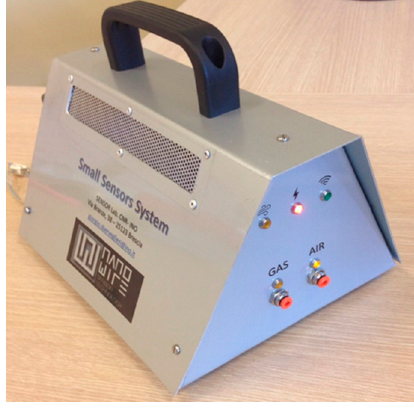
Figure 1. Portable S3 sensor device developed at SENSOR Laboratory, Brescia, Italy. Table 2. Sensor array characteristics, composition, morphology, and operating temperature.